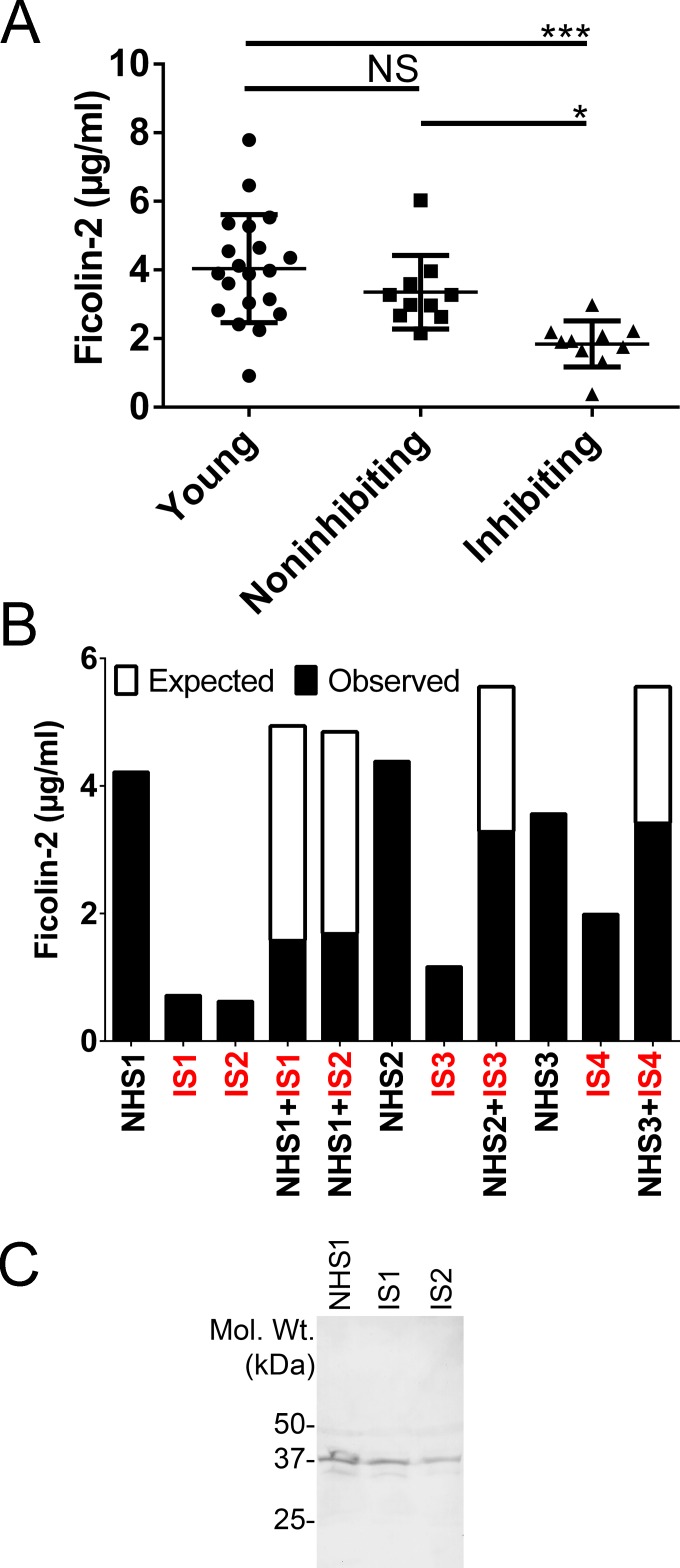
Inhibitors in archived sera interfere with an ELISA to quantify ficolin-2.(A) Ten inhibiting sera and ten noninhibiting sera were selected at random from UAB Study of Aging archived sera and assayed for ficolin-2 by a commercial ELISA. Each data point is shown along with mean and standard deviation. NS, not significant; *, P < 0.05; ***, P < 0.001 by one-way ANOVA with Tukey’s post-hoc test. Values for young, healthy controls were previously reported by our laboratory (Brady et al., 2014a). (B) Inhibitors in archived sera interfere with a commercial ficolin-2 ELISA. Three normal human sera (NHS1-3) and four inhibiting sera (IS1-4) were assayed by a commercial ELISA alone or in mixture. Mixtures were designed so that observed ficolin-2 would represent the sum of the samples (see Materials and Methods). Open bars represent the sum of the samples and thus the expected value of the assay. (C) Ficolin-2 immunoblot of sera tested in B suggests that IS1 and IS2 have comparable levels of ficolin-2 to NHS1. Ficolin-2 appears as a band of ∼37 kDa under these conditions.